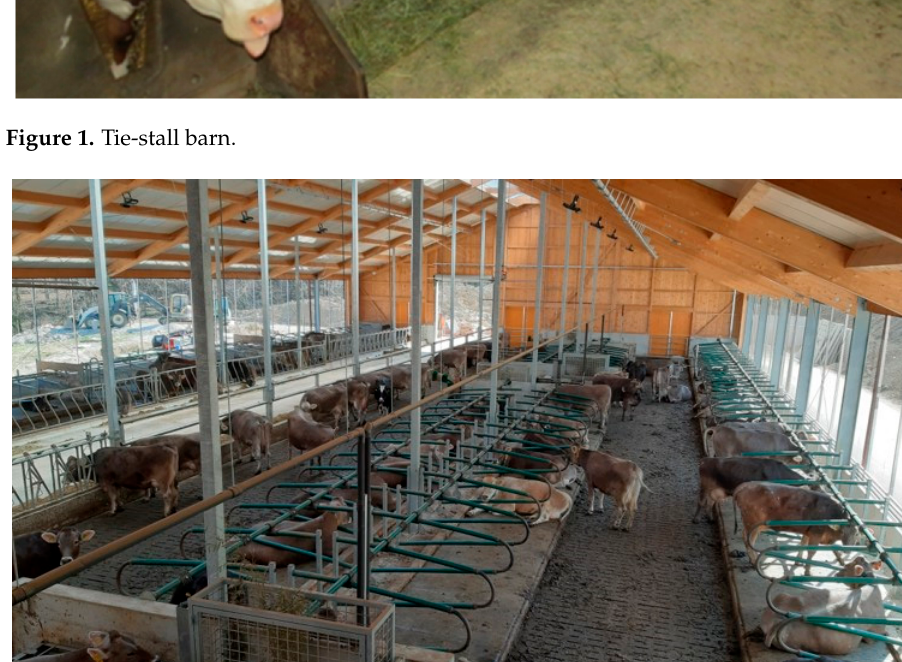
Figure 2. Freestall barn with cubicles.